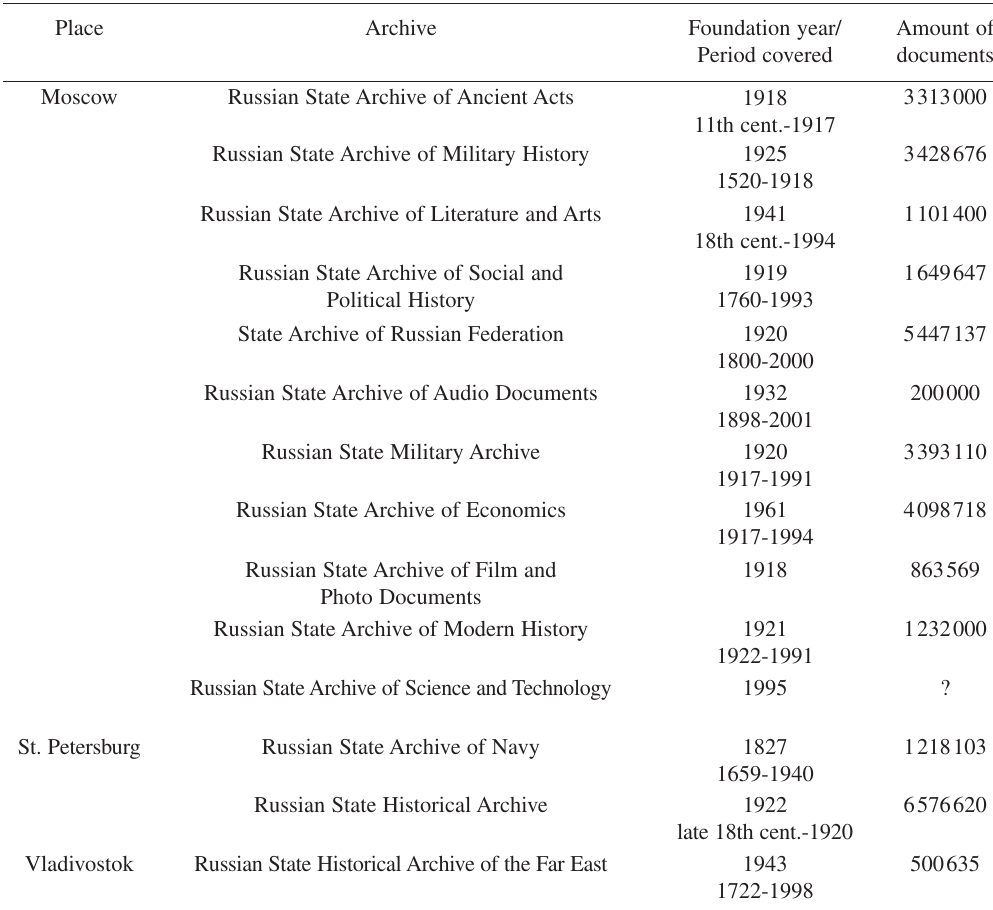
Table II. Federal archives of Russia (sorted by date of reported materials).